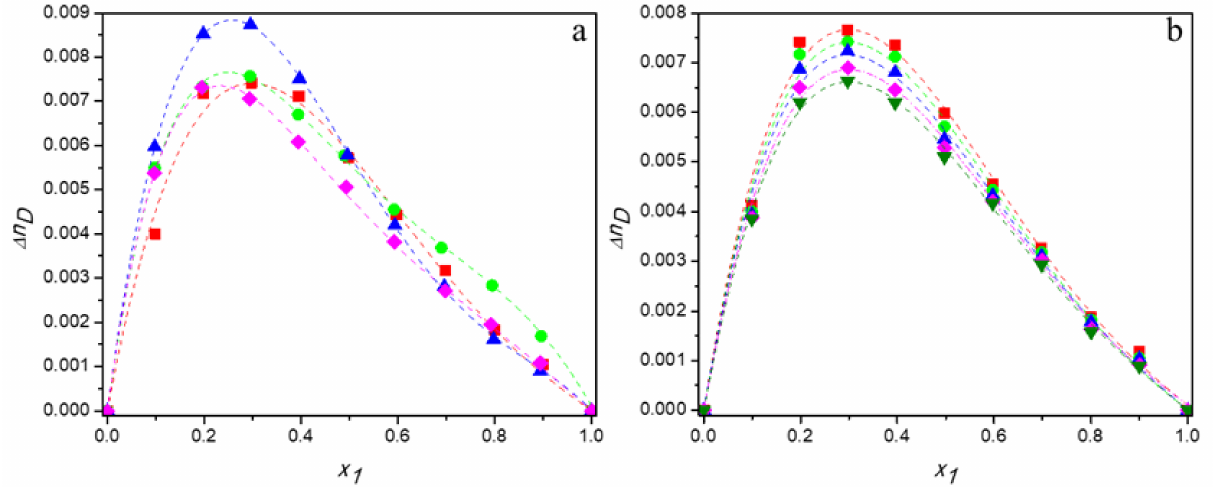
Figure 8. Dependence of the deviations in refractive of aqueous solutions of DESs on molar fraction of deep eutectic solvent: ( a ) 298. 15 K for (cid:4) DES1; • DES2; (cid:78) DES3; (cid:7) DES4; ( b ) for DES1 at 298.15 K ( (cid:4) ); 298.15 K ( • ); 303.15 K ( (cid:78) ); 308.15 K ( (cid:7) ); 313.15 K ( (cid:72) ); —, Equation